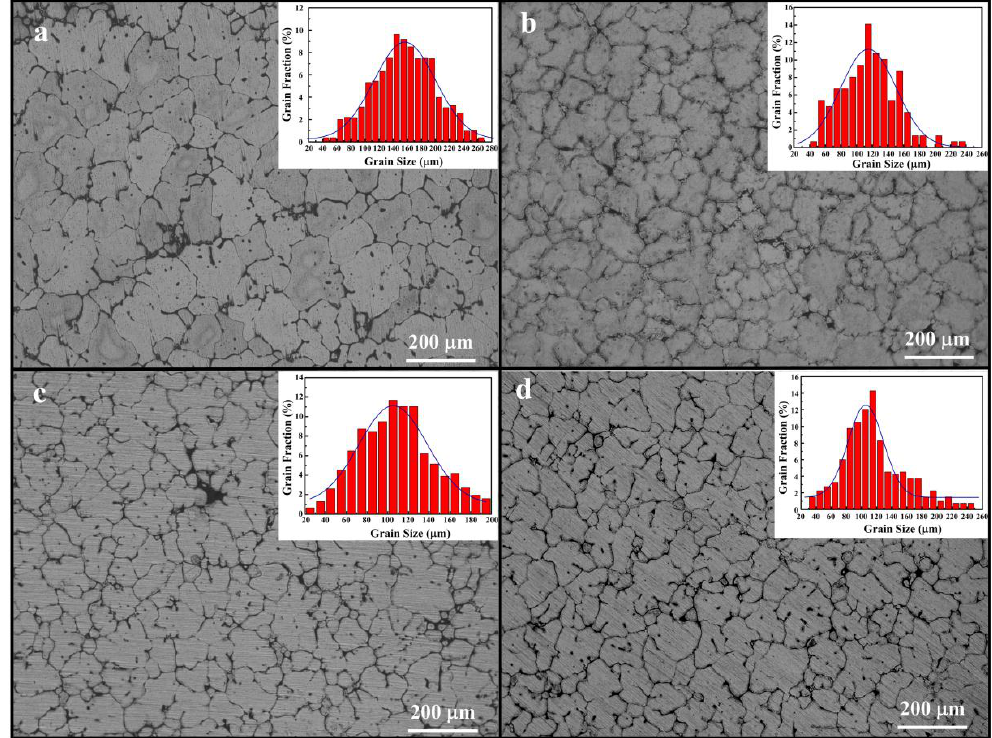
Figure 1. OM microstructures of as-cast 7075 Al alloys without and with various contents of Sr addition: ( a ) 0; ( b ) 0.05 wt. %; ( c ) 0.1 wt. %; and ( d ) 0.2 wt. % Sr (The grain size distribution is obtained from OM images by Nano Measure 2.1 and fitted by Origin 8.0 software with a Gaussion